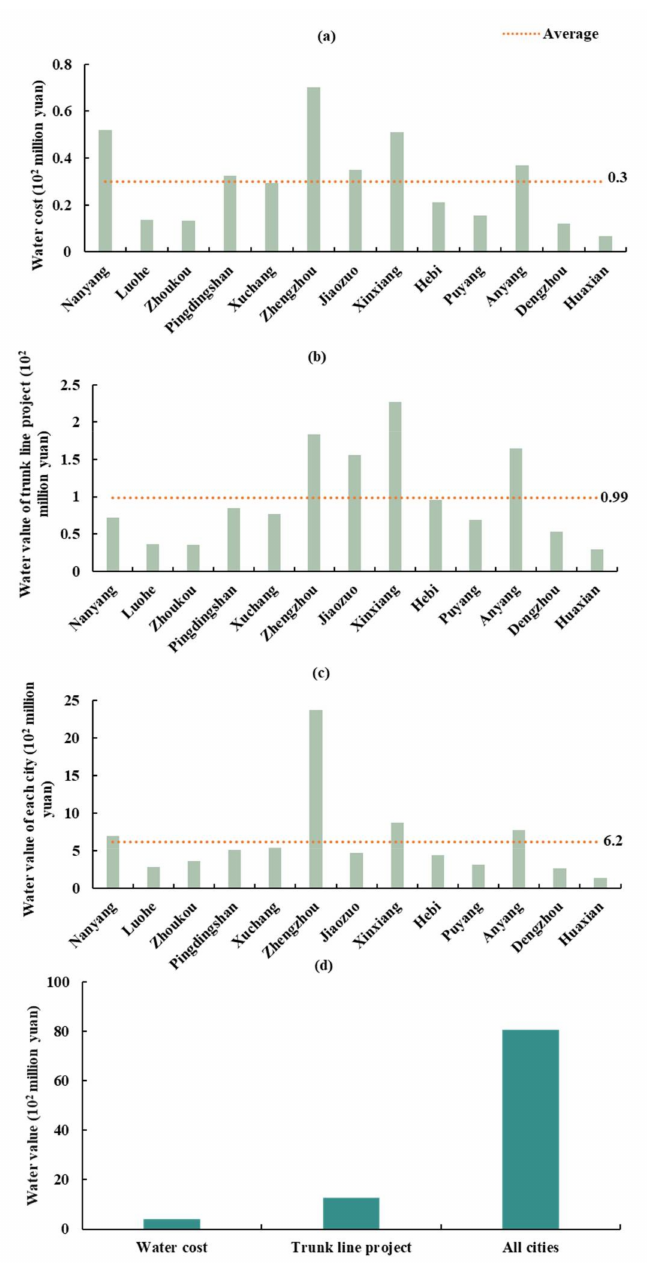
Figure 9. Water value in Henan province. ( a ) Water cost, ( b ) water value of the trunk line project, ( c ) water value of each city, and ( d ) comparison of water value for the above